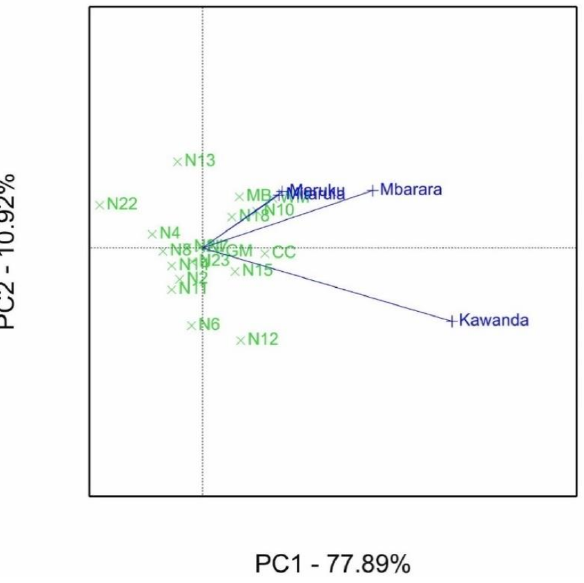
Figure 4. GGE biplot showing the relationship among the four test locations, based on black Sigatoka severity of 19 banana cultivars evaluated in Uganda and